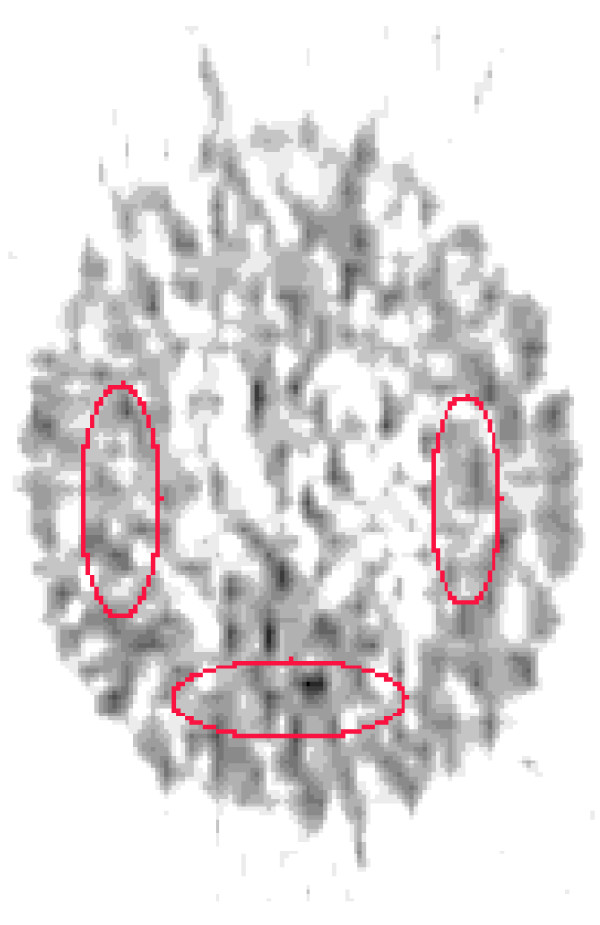
Regions of interest for 11C compartment and rate constant modelling. Upper left: right temporal region, upper right: left temporal region, bottom: occipital region.